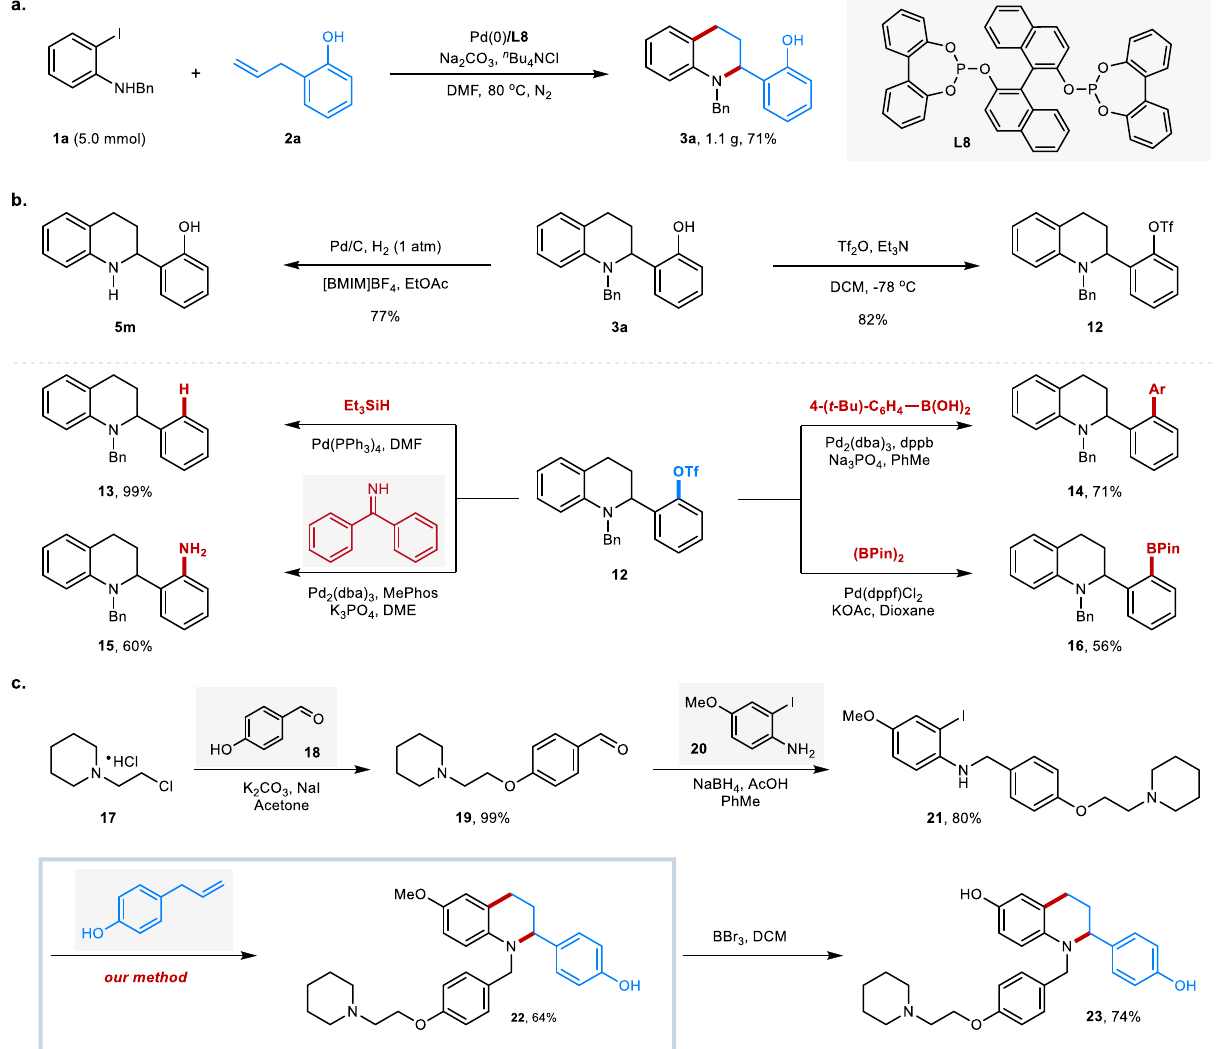
Fig. 6 | Gram-scale reaction and synthetic application. a Gram-scale reaction. b Transformation of the benzyl-protected tetrahydroquinoline. c Synthesis of potentialselectiveestrogenreceptormodulator(SERMs) 23 .Ac,acetyl;Ar,aryl;Bn, benzyl;Me,methyl;Et,ethyl;Ph,phenyl;(Bpin) 2 ,bis(pinacolato)diboron;DMF, N , N -